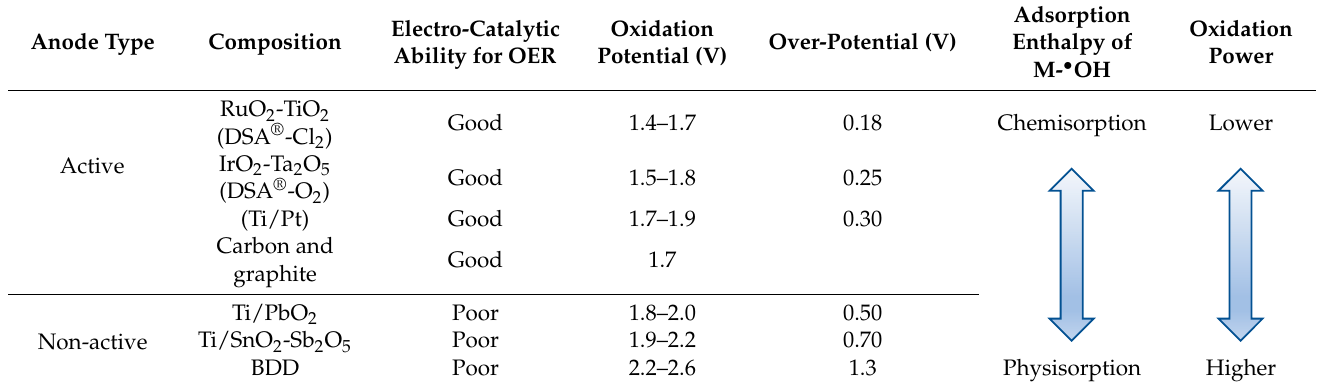
Table 10. Categorization of anodic electrode materials based on oxidation power and potential for OER in acidic media [110].